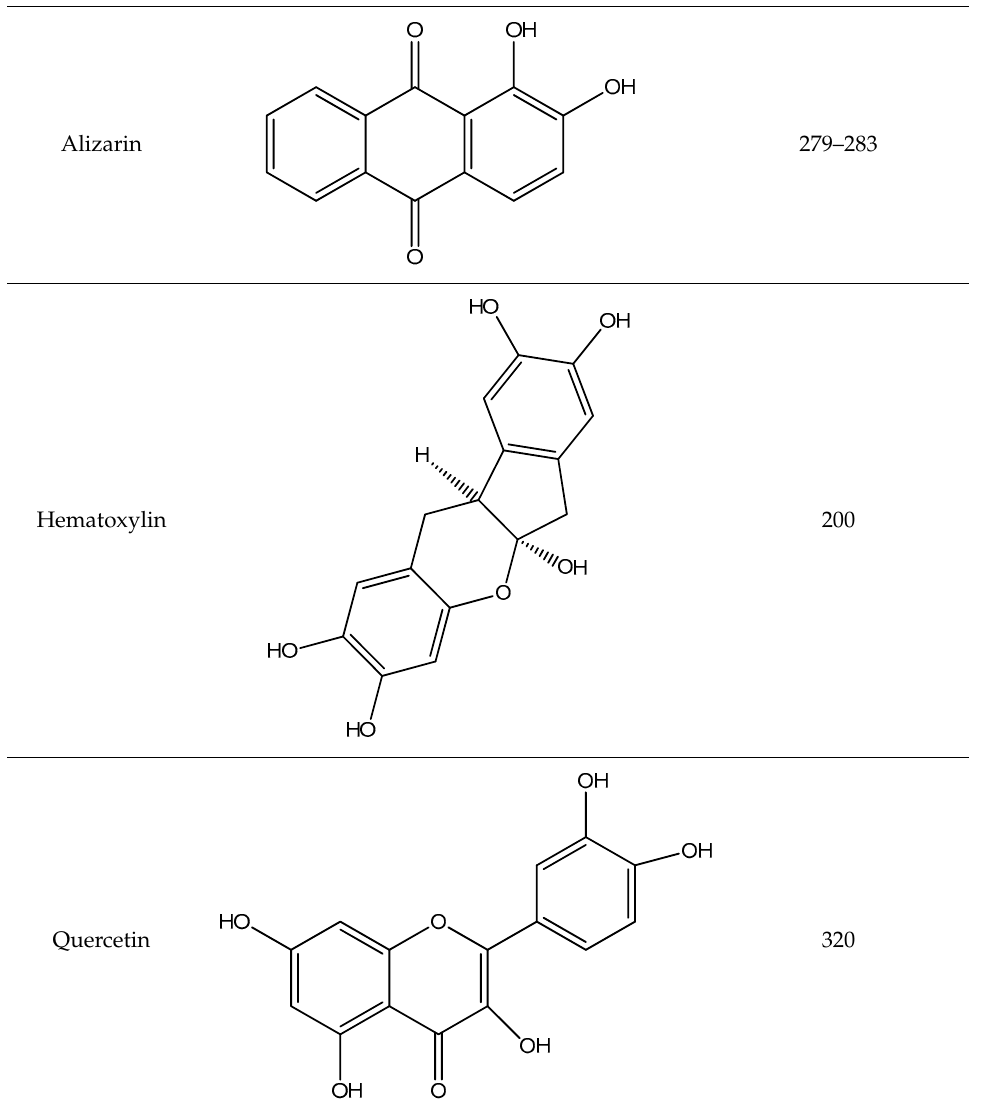
Table 1. Chemical structures and melting points of the dyes alizarin, hematoxylin and quercetin. Dye